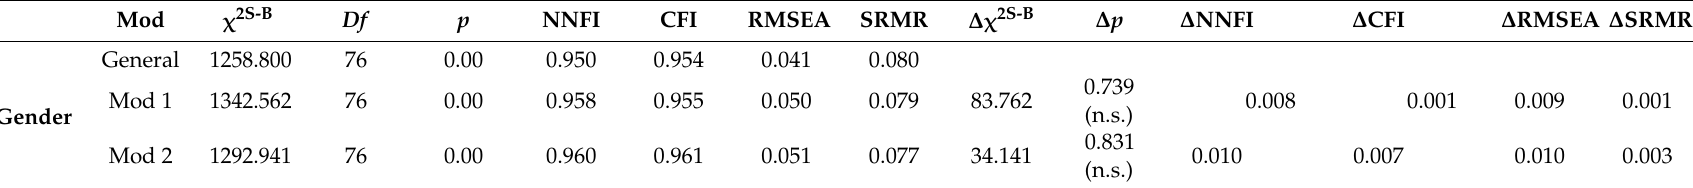
Table 3. Gender configuration invariance analysis of the